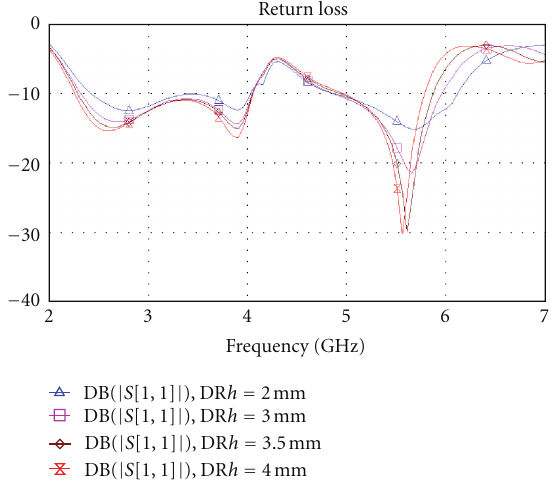
Figure 4: Simulation return loss of hybrid antenna with di ff erent rectangular patch length.